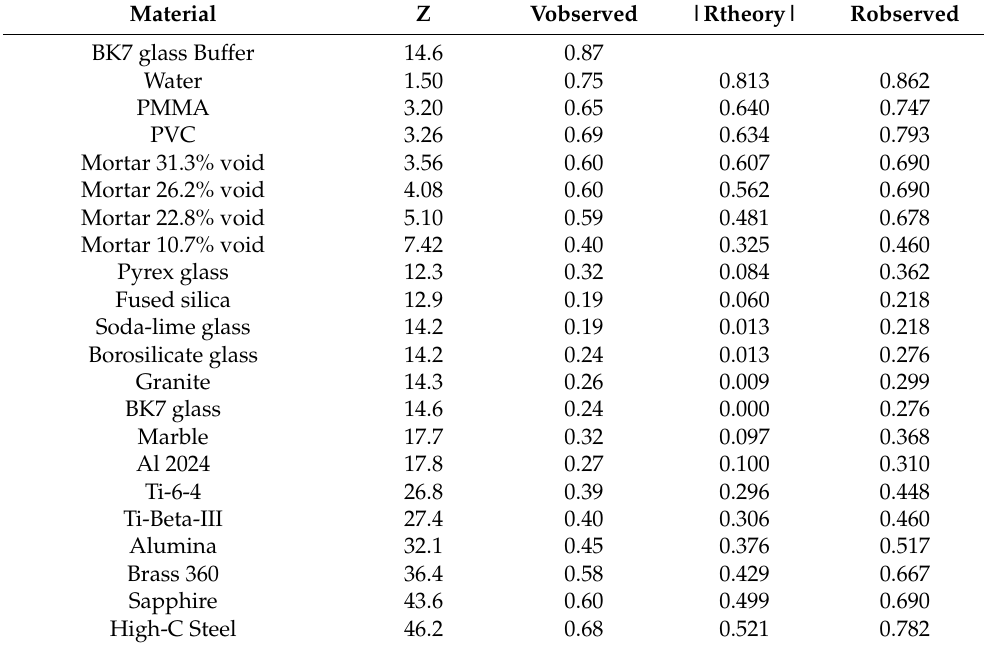
Figure 3. Calculated R th magnitude using Equation (2) (shown by blue dots) and experimentally obtained R using BS and IF signal amplitude (red dots) for 21 different materials from water to hardened steel. Data is listed in Table 1. Table 1. Acoustic Impedance and Reflection Coefficients.